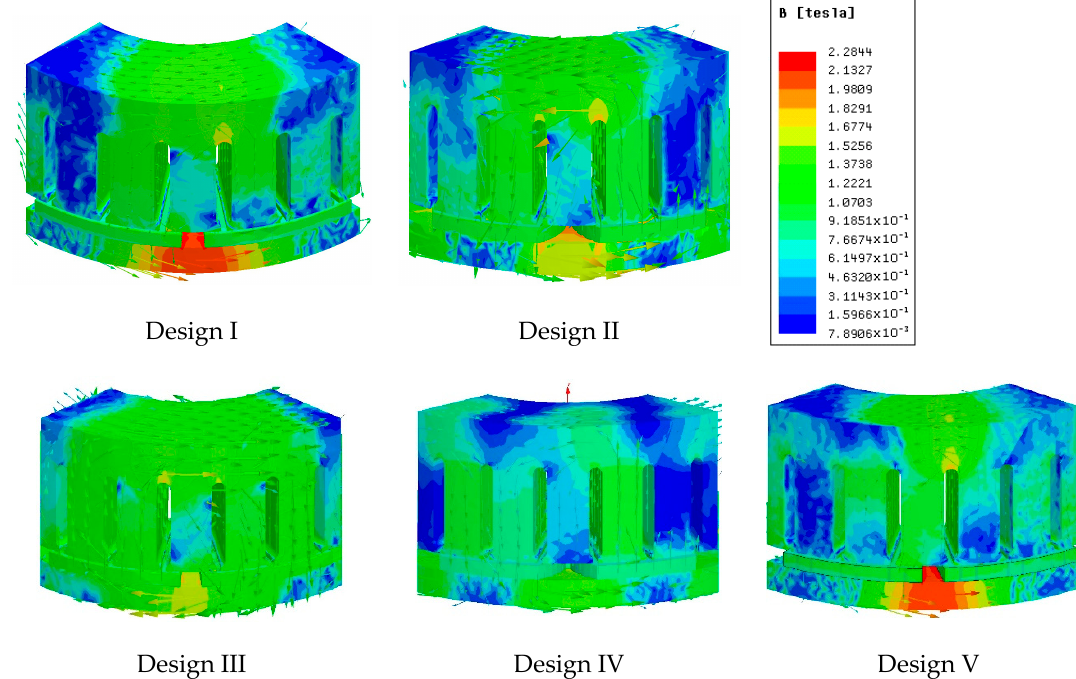
machine (for 90 mechanical degrees). 4